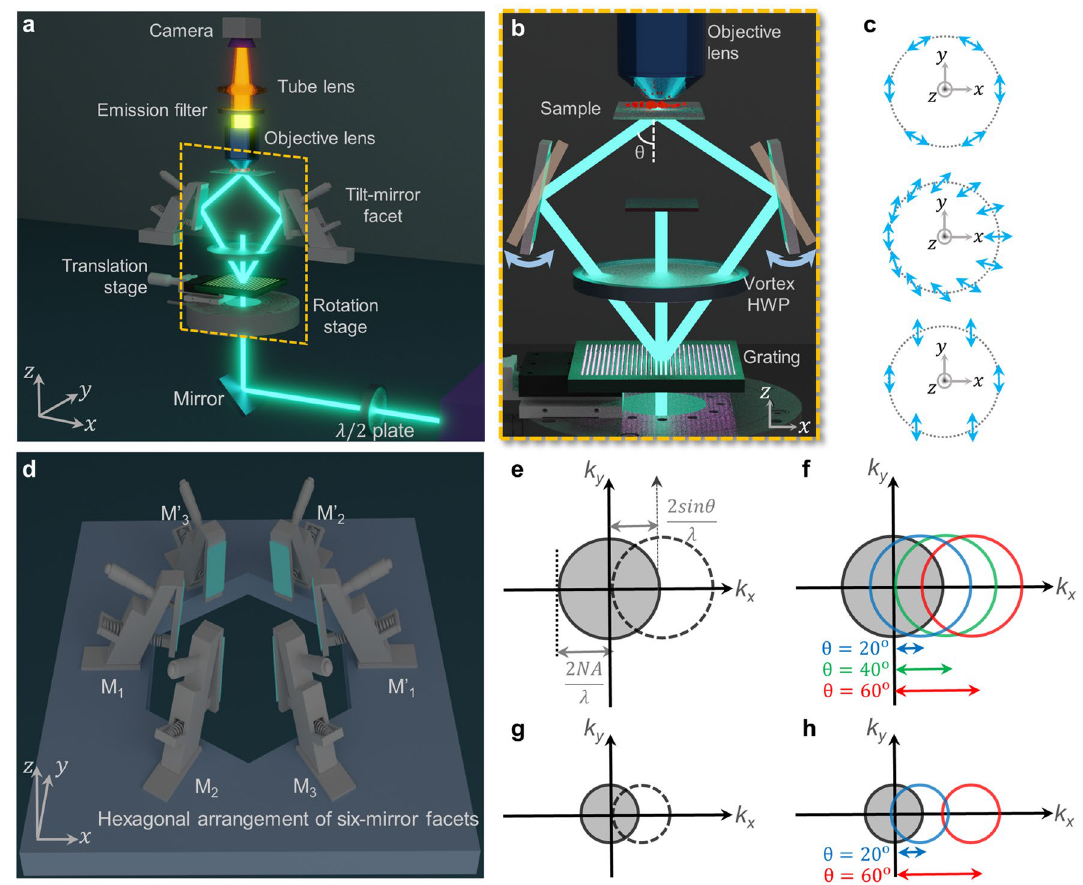
Figure 1. Concept of tSIM: ( a ) scheme of the experimental setup for one orientation; ( b ) tunable frequency illumination patterns are generated by a pair of mirror facets corresponding to low and high frequency illumination respectively; ( c ) scheme of polarization conversion of the interfering beams where top, middle and below panel corresponds to the state of polarization above, on and below the vortex half wave plate respectively; ( d ) hexagonal arrangement of mirror-facets for three orientation angles required for isotropic resolution enhancement; ( e ) resolution limit represented by the optical transfer function (solid circle), maximal shift (dotted circle) in conventional SIM offers two-fold resolution enhancement. ( f ) maximum spectral support of (cid:31) θ ; ( g , h ) frequency support tSIM governed by with periodicity 2sin θ 1 , tunable under different interfering angles of a low-NA detection objective lens under similar illumination configurations, where tSIM support more than conventional 2X resolution enhancement of SIM. The 3D graphics shown in (a, b, d) are designed using a free and open-source software for 3D computer graphics, Blender (Version 3.2, https:// www. blend er. solely depends upon the interference conditions where (cid:31) ex is the peak excitation wavelength and θ is the semi interference angle between the interfering beams within a medium of refractive index n . Hence, the theoretical lateral resolution limit of the tilt-mirror based tSIM is determined as, (cid:31) em � = (2) n sin θ 2 NA + (cid:31) em (cid:31) ex (cid:30) (cid:31) The semi-angle of interference ( θ = 2 δ + α ) is governed by the diffraction angle ( α ) of the grating and the incli- nation ( δ ) of the mirror with respect to the optics axis. Tuning the tilt angle of the mirror leads to the change in the interference angle and also in the pattern frequency. Hence, the technique is capable to generate the tunable frequency sinusoidal structured patterns depending upon the requirement of the illumination scheme. This particular characteristic is quite unique relative to the standard SIM technologies existing so far. The close-up view within the yellow-box in Fig. 1a is shown by Fig. 1b, representing the angle-tuning scheme for the illumina- tion. The desired phase-shifting of the interference pattern in the sample plane is incorporated by shifting the physical grating along the lateral (along the grating period) direction with a single-axis piezo-translation stage. The piezo-stage is coupled with a motorized rotation stage which changes the orientation of the grating to incor- porate isotropy in the illumination patterns. In order to create the illumination pattern of highest modulation depth, the polarization states of the interfering beams pairs are suitably converted before hitting the mirrors. Figure 1c represents the conversion scheme of the state of polarization: linearly polarized input (bottom panel),